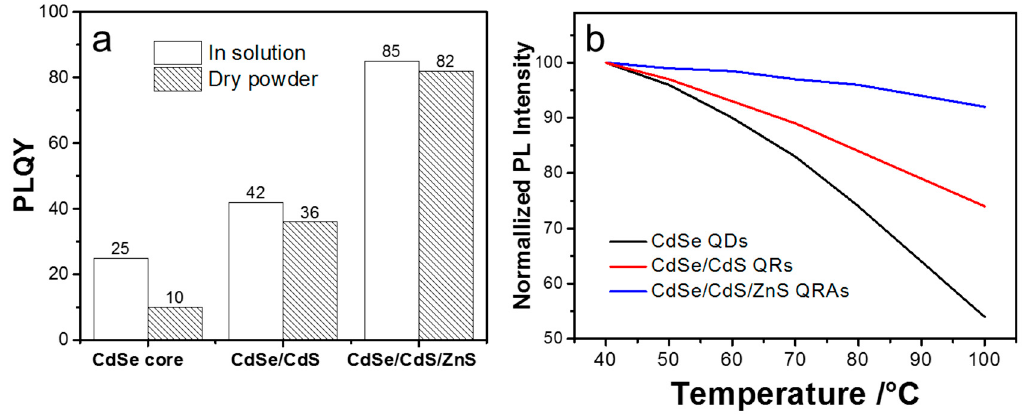
Figure 5. ( a ) Photoluminescence quantum yield (PLQY) of the CdSe QDs, CdSe / CdS QRs, and CdSe / CdS / ZnS QRAs in solution and in dry powder form; ( b ) fluorescent quenching of the materials at different temperatures.